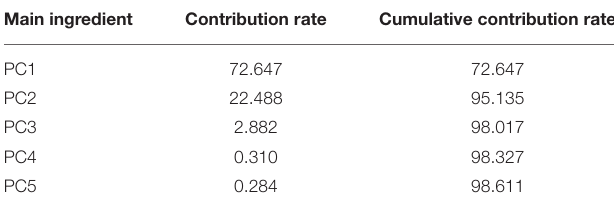
TABLE 4 | Contribution rate and cumulative contribution rate of the first five principal components (alkaline